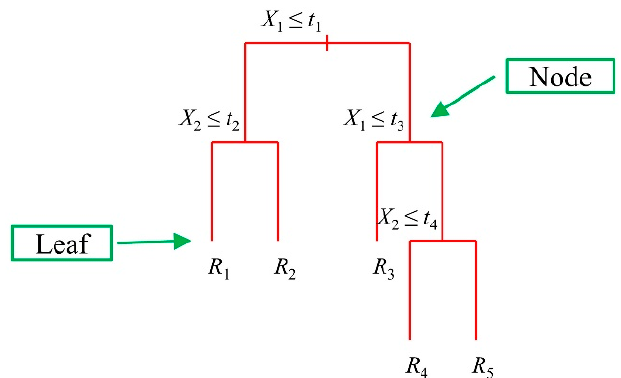
Figure 1. Decision tree example (adapted from Hastie et al. [58], p.306). X j denote predictor variables. The tree has four internal nodes and five leaves (terminal nodes). X j ≤ t k and X j > t k correspond to the left and right branches of each internal split, respectively. R i denotes the mean of the observations at leaf i [39] (p. 304).